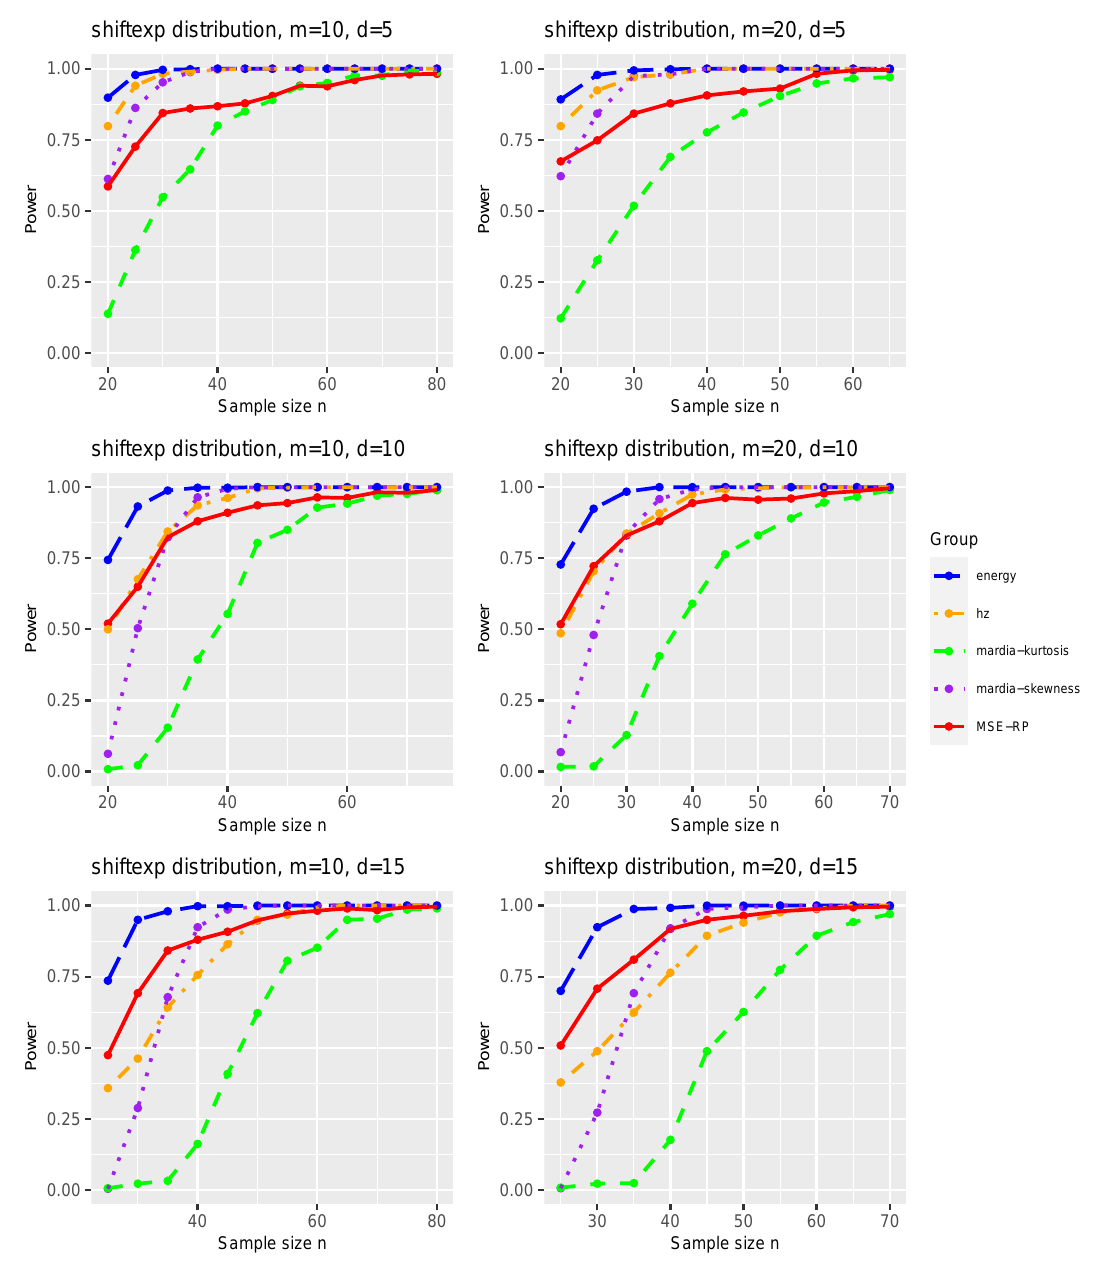
Figure A3. Power ( α = 0.05) comparison for shifted i.i.d. exp ( 1 )